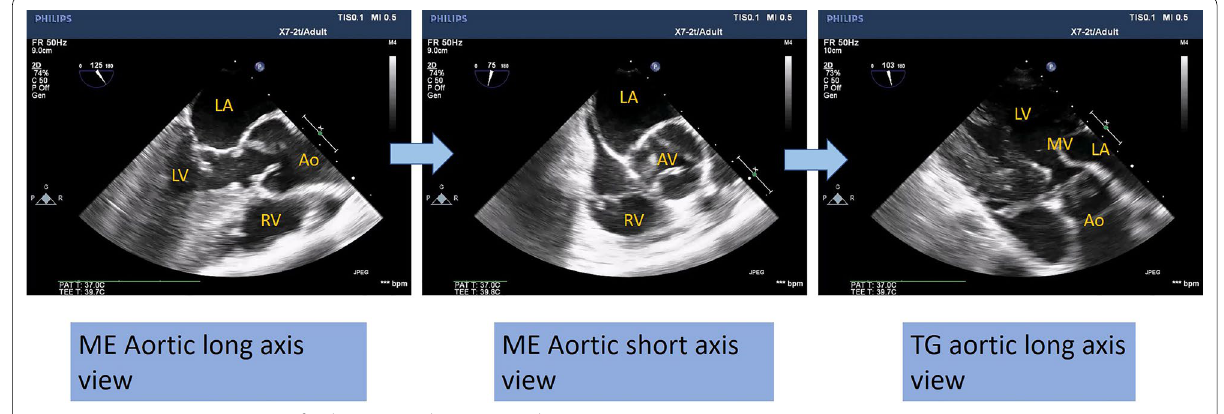
Fig. 2 2D TOE imaging sequence for the aortic–subaortic complex